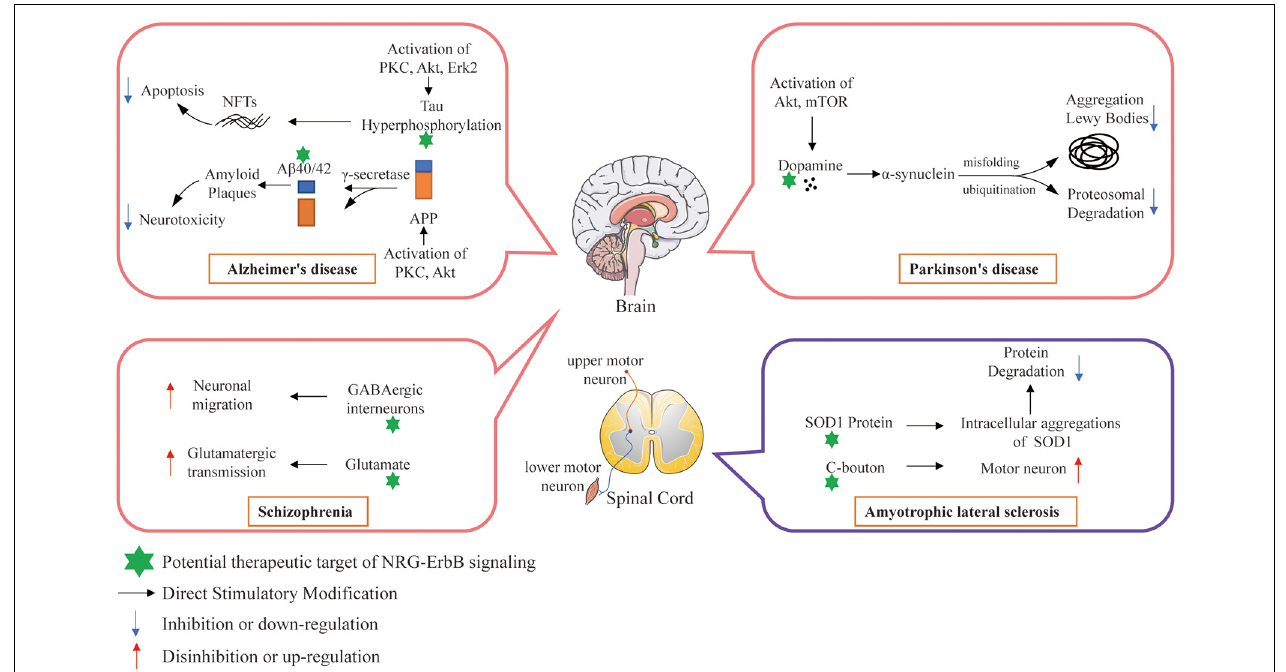
FIGURE 5 | Potential therapeutic targets of NRG/ErbB signaling involved in selected neurodegenerative diseases.